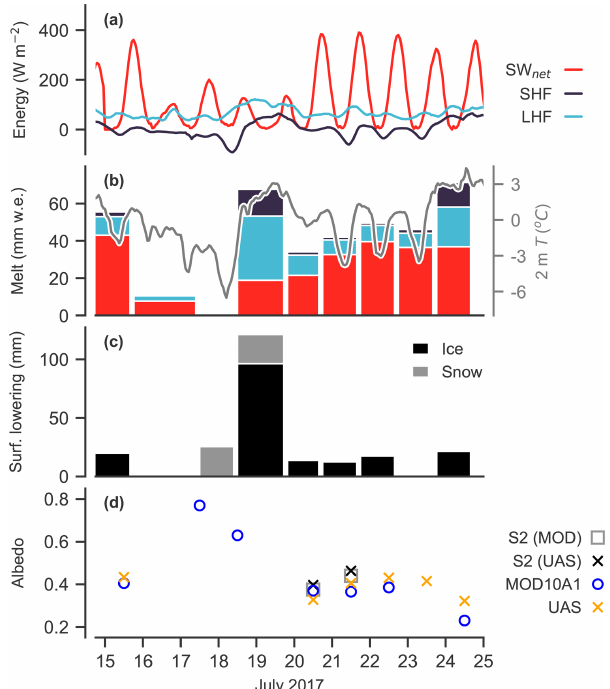
Figure 3. Time series of energy fluxes, models, surface melt rates, surface lowering and sensor albedos. (a) Energy balance com- ponents derived from surface energy balance model (Sect. 3.7). (b) Left: melt fluxes in millimetres water equivalent (bars) estimated with surface energy balance model, split into responsible energy flux by colour, for each period of measured surface lowering. Right: 2m air temperature (line) from IMAU S6 AWS. (c) Mean measured surface lowering (mm) across the UAS area. (d) Albedo measured by UAS, S-2 within UAS area, S-2 within the MOD10A1 pixels and mean MOD10A1